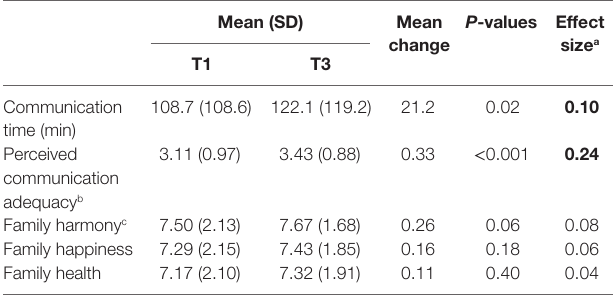
TaBle 2 | The mean change of family communication and family 3Hs in the intervention